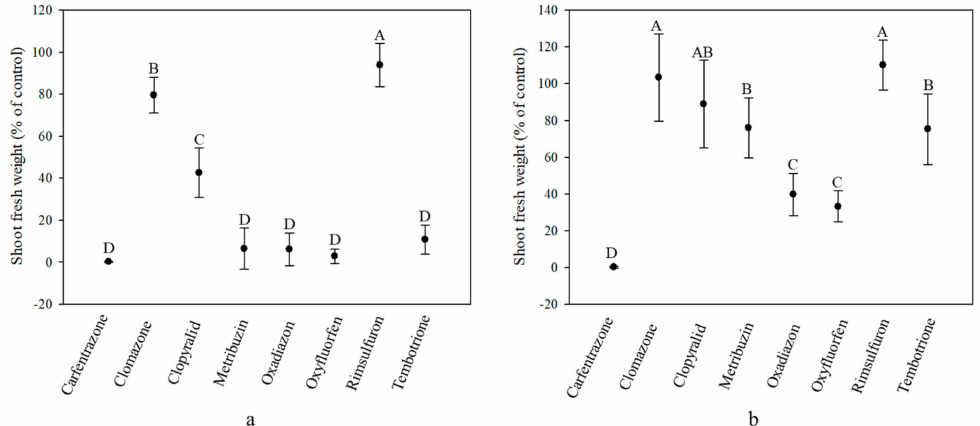
Figure 2. Shoot fresh weight (% of control) of Solanum rostratum plants from the Ginegar population treated with the recommended field rate of various herbicides at the 4–5 cm ( a ) and 8–9 cm ( b ) growth stages. Shoot fresh weight was recorded 21 days after herbicide application. Different uppercase letters indicate statistically significant differences among treatments, as determined by a Tukey–Kramer HSD test ( α = 0.05).